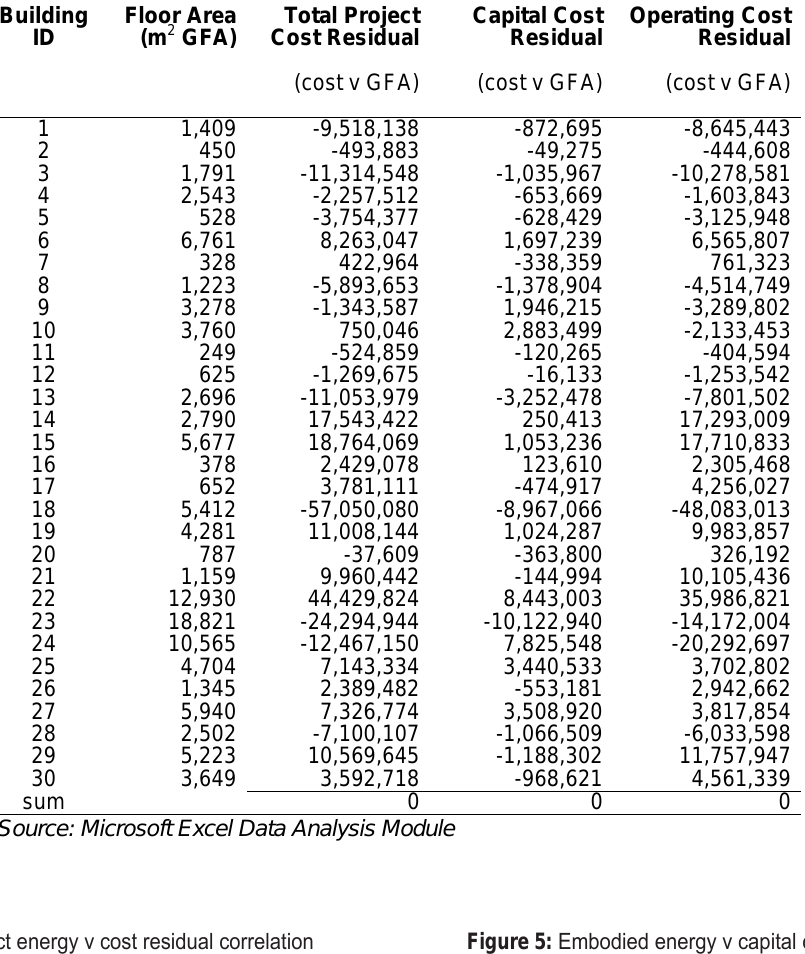
Table 5: Case study cost residual summary